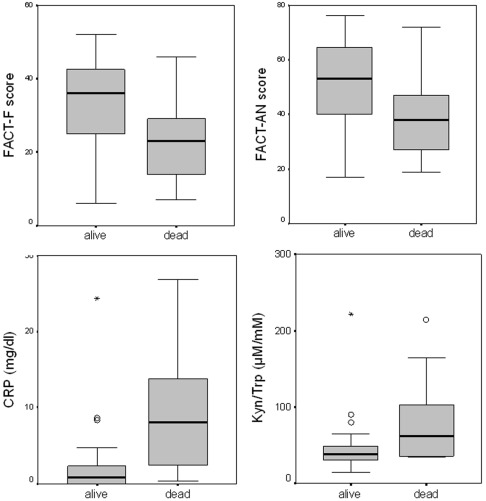
FACT-F (upper left) and FACT-AN scores (upper right) as well as concentrations of C-reactive protein (CRP; lower left) and kynurenine to tryptophan ratios (Kyn/Trp; lower right) of patients with lung cancer who have died (n = 10) or were still alive or after 3 months of follow-up (all group comparisons between alive and dead p<0.01).